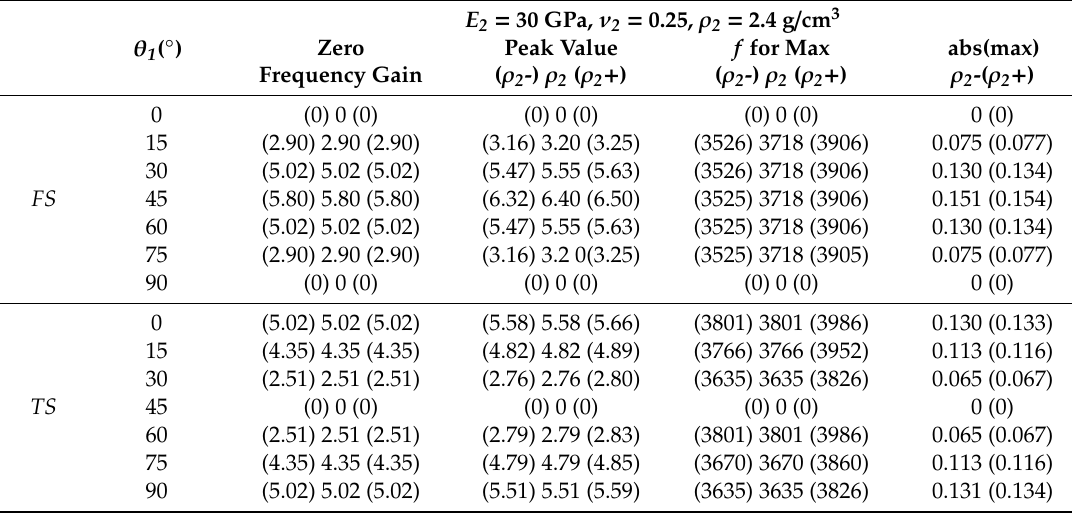
Table 8. Influence of the expansive grout density on theoretical amplitude spectrum of gauge combinations FS and TS for the incident S